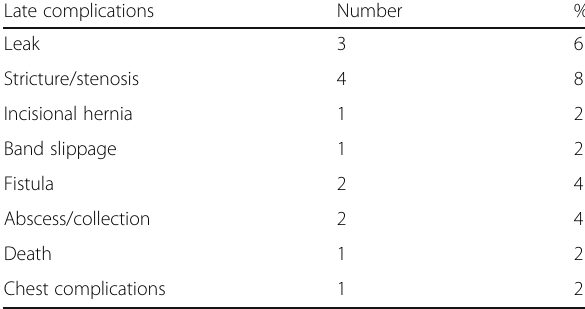
Table 3 Late complications of studied